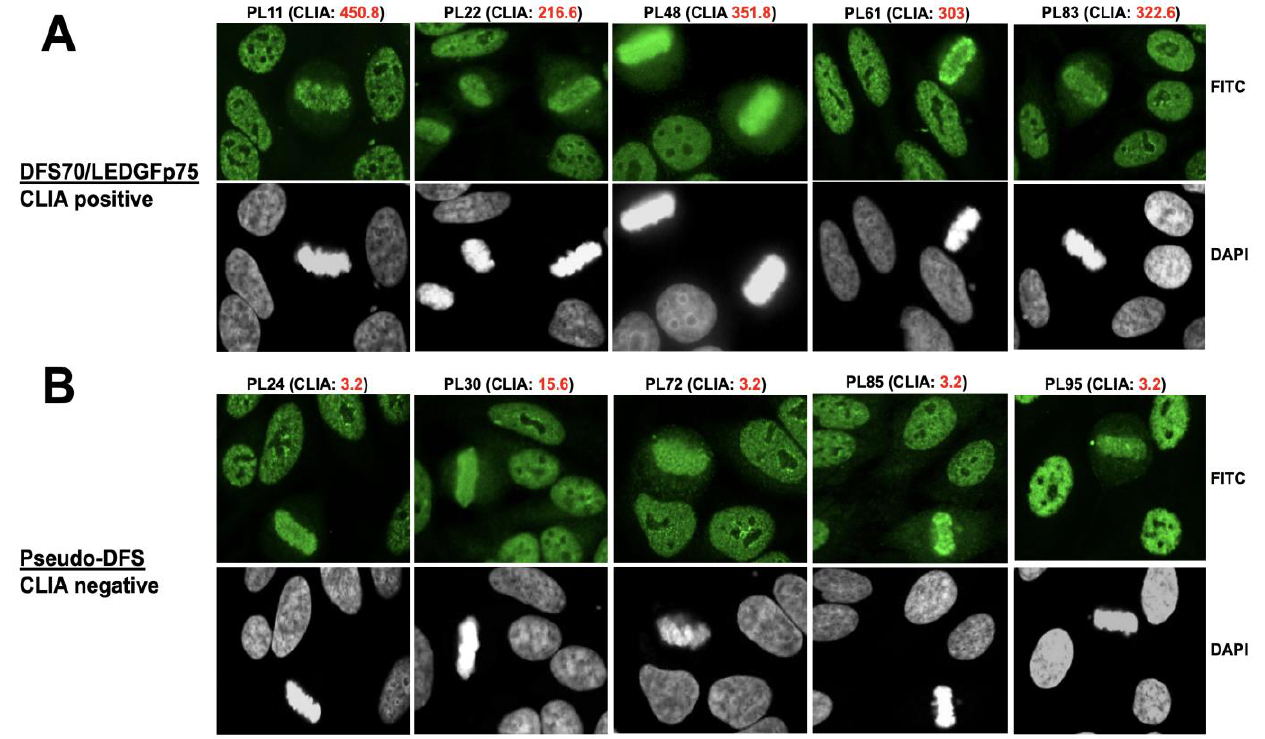
Figure 1. Indirect immunofluorescence images of human sera presenting the monospecific nuclear dense fine speckled (DFS) pattern. ( A ) Selected sera positive by QUANTA Flash DFS70 chemilumi- nescence assay (CLIA) show the DFS IFA pattern corresponding to DFS70/LEDGFp75 antibodies in HEp-2 cells. ( B ) Selected CLIA anti-DFS70-negative sera showing a pseudo-DFS IFA pattern in HEp-2 cells. Images were obtained by confocal microscopy. Chromatin staining with DAPI is presented in black and white for better visualization.